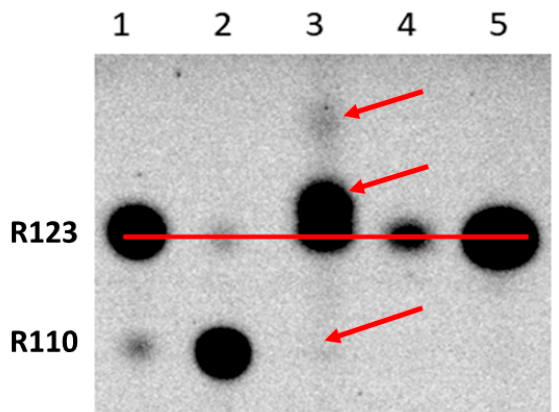
Figure 4. Thin-layer chromatography of butanol extracts of glioma cells and astrocytes treated with Rh123 followed by a long wash. 1st lane, commercial sample of rhodamine 123; 2, commercial sample of rhodamine 110; 3, glioma cells incubated for 2 h with Rh123 (2 µM) and then in pure cultivation medium pure for 22 h; 4, astrocytes incubated 2 h with Rh123 and then for 22 h in pure incubation medium; 5, glioma cells incubated for 2 h with Rh123 (2 µM) and amiodarone (2 µM), and then in pure incubation medium for 22 h. Two arrows at the top indicate modified fluorescent products. For a relative assessment of the mobility of the spots, a horizontal line is drawn along the centers of the spots corresponding to Rh123. The arrow at the bottom indicates the absence of the spot corresponding to